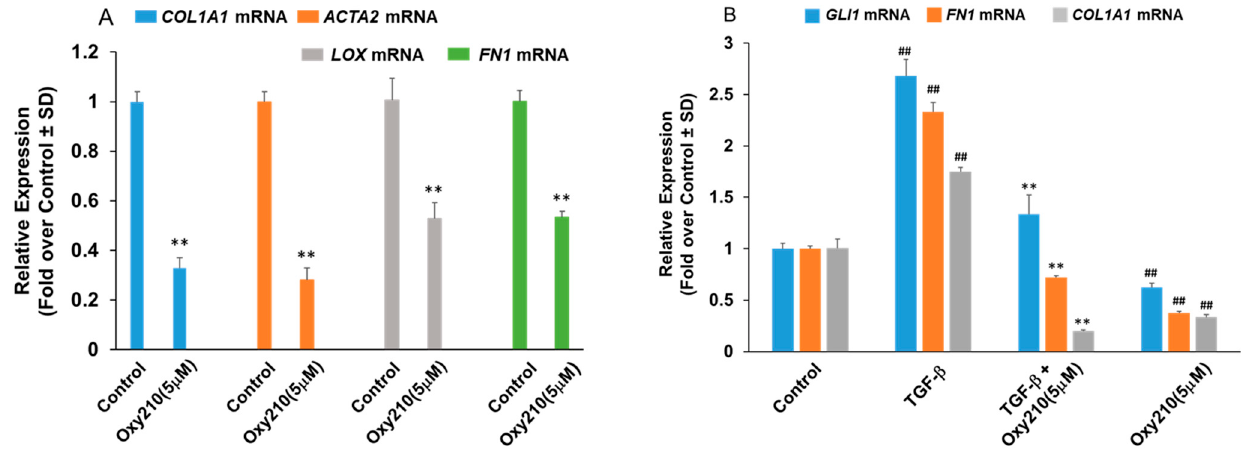
Figure 5. Effect of Oxy210 on basal and TGF- β -induced expression of fibrotic genes in primary human pericytes. ( A ) Human pericytes were treated with control vehicle or Oxy210 for 48 h in DMEM containing 1% FBS. RNA was extracted and analyzed by Q-RT-PCR for the expression of pro-fibrotic genes and normalized to GAPDH expression. Data from a representative experiment are reported as the mean of triplicate determinations ± SD (** p < 0.01 vs. control). ( B ) Human pericytes cultured in DMEM containing 1% FBS were treated with TGF- β 1 (10 ng/mL) in the absence or presence of Oxy210 for 48 h. RNA was extracted and analyzed by Q-RT-PCR for the expression of pro-fibrotic genes and normalized to GAPDH expression. Data from a representative experiment are reported as the mean of triplicate determinations ± SD (## p < 0.01 vs. control; ** p < 0.01 vs. TGF- β ).